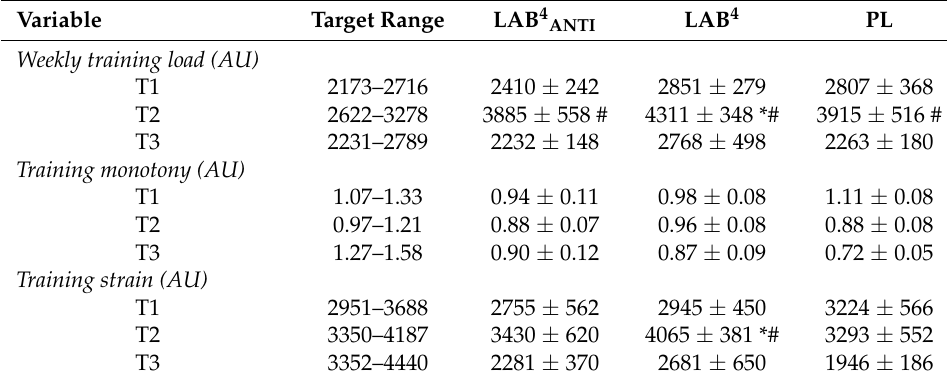
Table 3. Training load